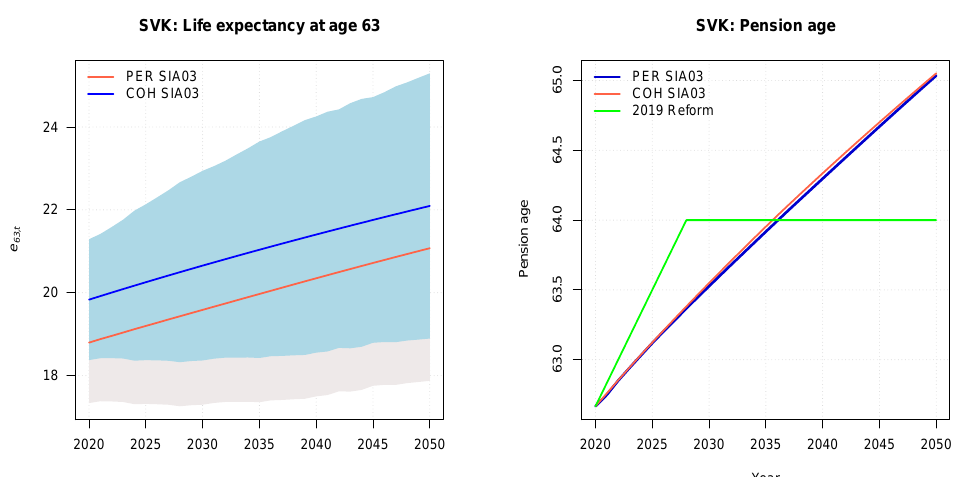
Figure 10. SVK: BME forecast of unisex period and cohort life expectancy and pension age along with 95% prediction intervals.